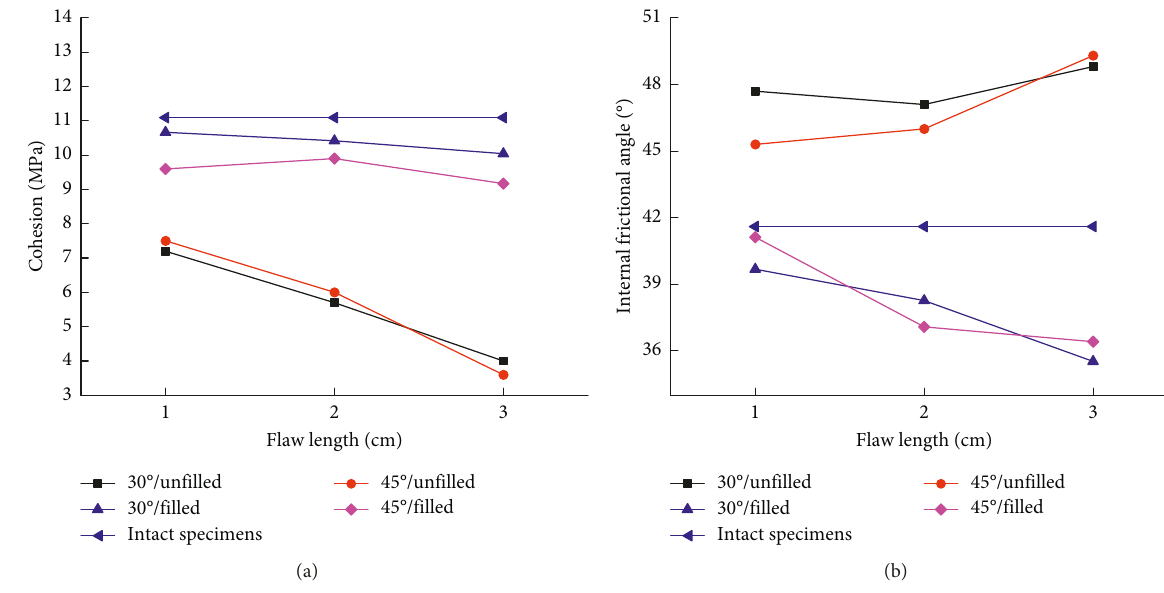
Figure 13: Cohesion (a) and internal friction angle (b) of the samples containing grout-infilled and unfilled